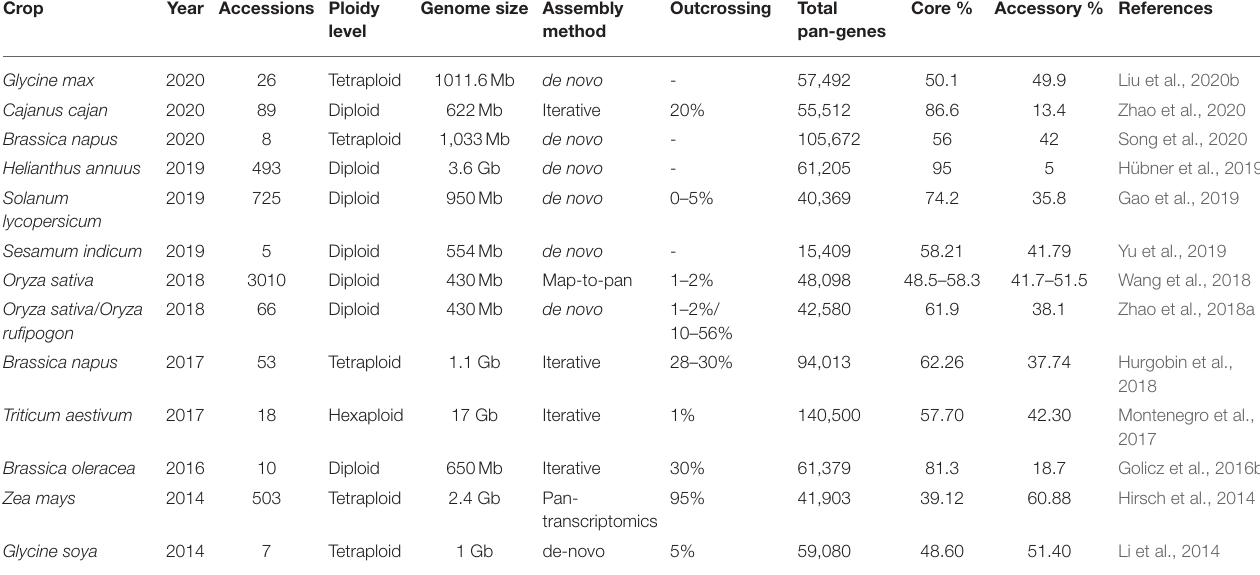
TABLE 1 | Summary of major crop pan-genomic studies.